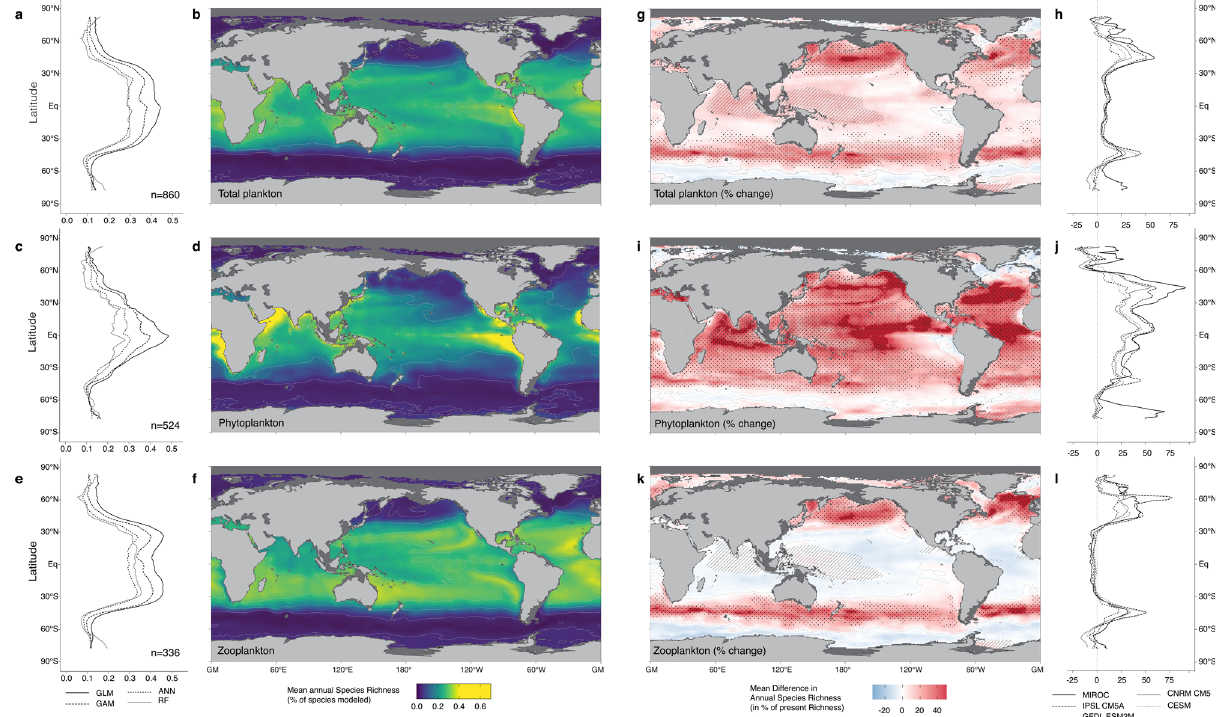
Fig. 1 Global patterns of annual mean species richness (in % of species modeled) of plankton ( fi rst row), phytoplankton (second row) and zooplankton (third row) in the contemporary surface ocean (left two columns) and their projected changes for the 2081 – 2100 period under the representative concentration pathway RCP8.5 scenario (right two columns). a , b The annual mean species richness for all 860 phyto- and zooplankton species modeled. Shown is the mean richness across all 16 ensemble members (4 species distribution models and 4 predictor pools), c , d same as a – b but for the 336 modeled phytoplankton species. e , f same as a , b , but for the 524 zooplankton species. a – e show the zonal averages separately for each of the four statistical models. g , h the percentage difference in species richness induced by future climate change for all plankton species. Shown is the mean across all 80 ensemble members (4 species distribution models, 4 predictor pools, 5 earth system models. I , j same as g , h but for phytoplankton. k , l same as g , h but for zooplankton. h – l show the corresponding zonal averages in percentage difference for each of the 5 earth system models. The gray contour lines represent the isopleths for 50 units of mean annual species richness in b – f and for 25% of species richness difference in g – k . Regions in darker red highlight gains in annual SR larger than 50%. Stippling in g – k marks the regions where at least 90% of the 80 ensemble agree on the direction of the change. Hatching marks the region where non-analog conditions emerge in the future ocean on an annual scale. Total sample size is N = 35,023 grid